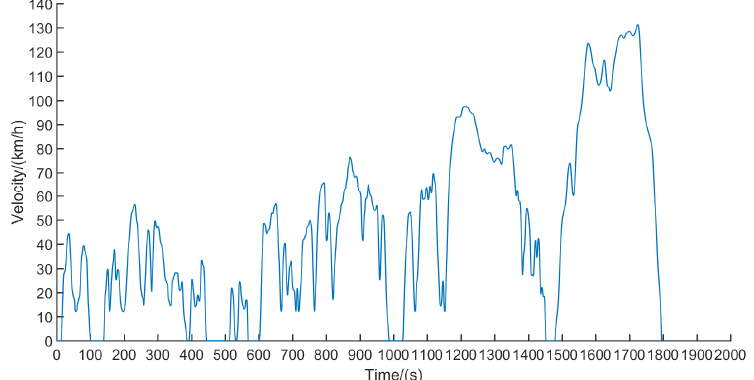
Figure 10. The velocity profile of the Worldwide-Harmonized Light-Vehicle Test Procedure (WLTP). Table 3. WLTP velocity profile configurations.